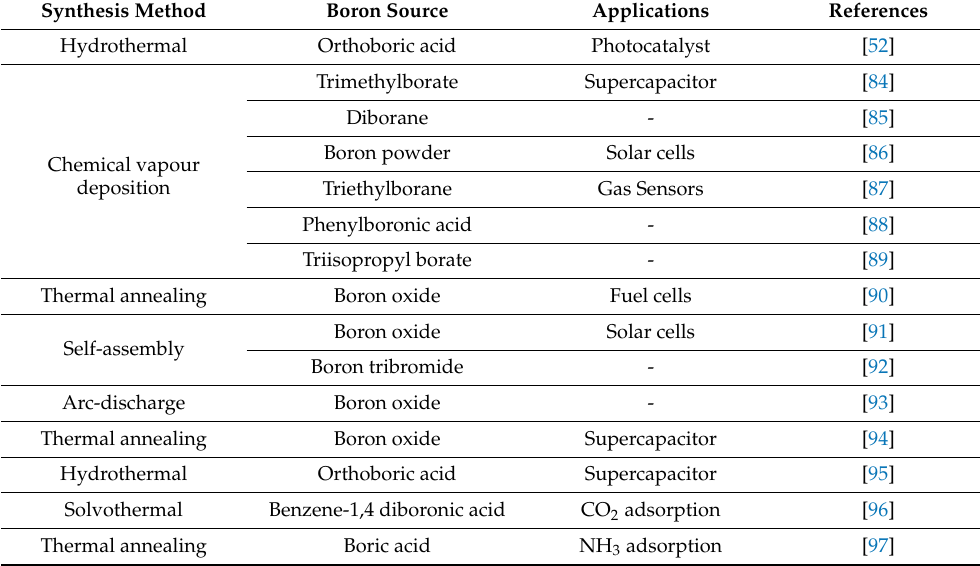
Table 2. Different approaches for synthesis of